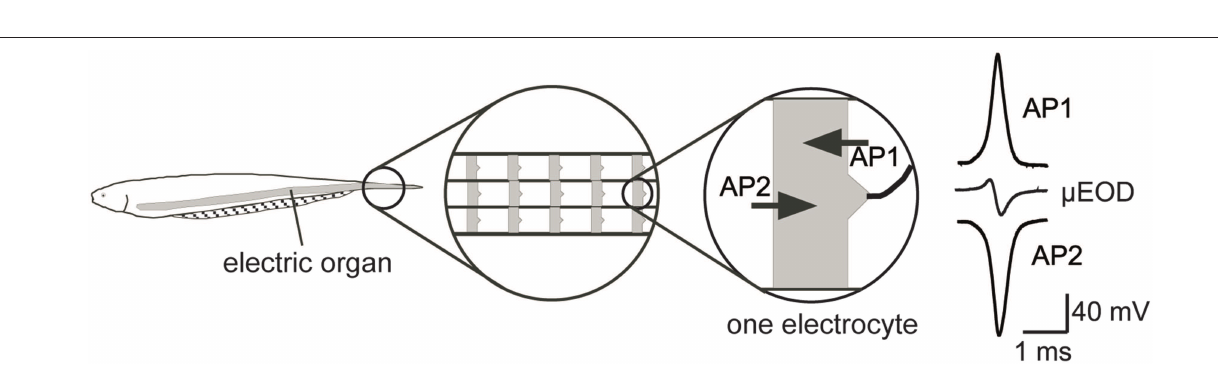
FIGURE 8 | The biphasic EODs of B. gauderio and others are produced at the level of the single electrocyte by a pair of action potentials (APs) driving sodium currents in opposite directions (AP1 headward, AP2 tailward). The action potentials are temporally offset, which produces a biphasic micro-EOD when the two currents sum outside the cell. The temporal offset is only partial, however, so the current from each action potential partially cancels out the other. Thus, the 2nd EOD phase that balances the EOD to reduce predation risk also wastes significant energy. Adapted from Stoddard (2002a), Markham and Stoddard (2005), and Stoddard and Markham (2008) with permission of the